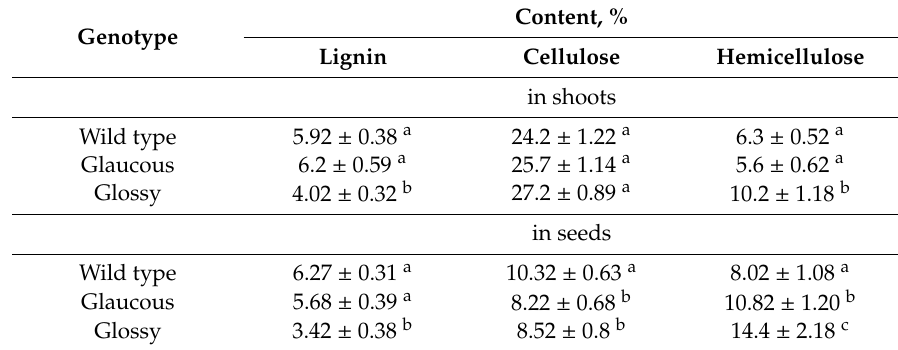
Table 3. Content of lignin, cellulose, and hemicellulose in shoots and seeds of WT and mutant plants.